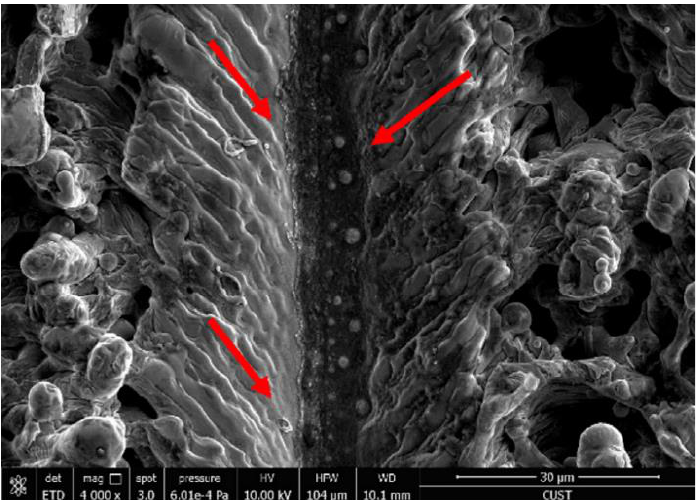
Figure 14. High pulse times lead to recoagulation at the bottom of the groove (molten material flows in the direction of the red arrow) (Reprinted with permission from Ref. [64]. 2017, Yang, Z.).